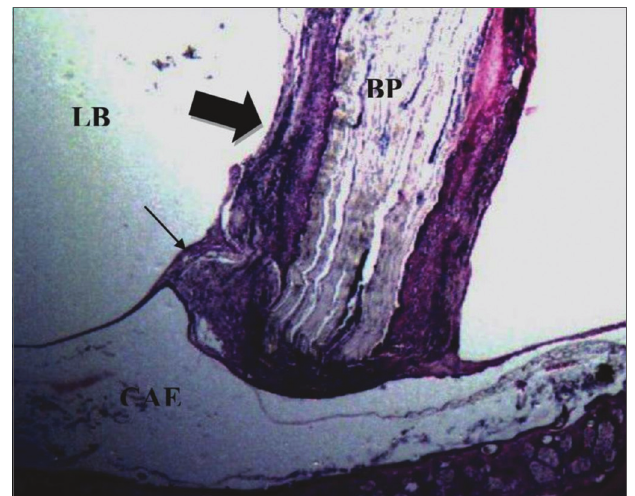
Figura 1. Grupo controle. Fotomicrografia da fáscia aderida à mucosa da bula timpânica. LB= luz da bula; OT = Osso temporal; seta fina= fáscia. HE(aumento 100x).